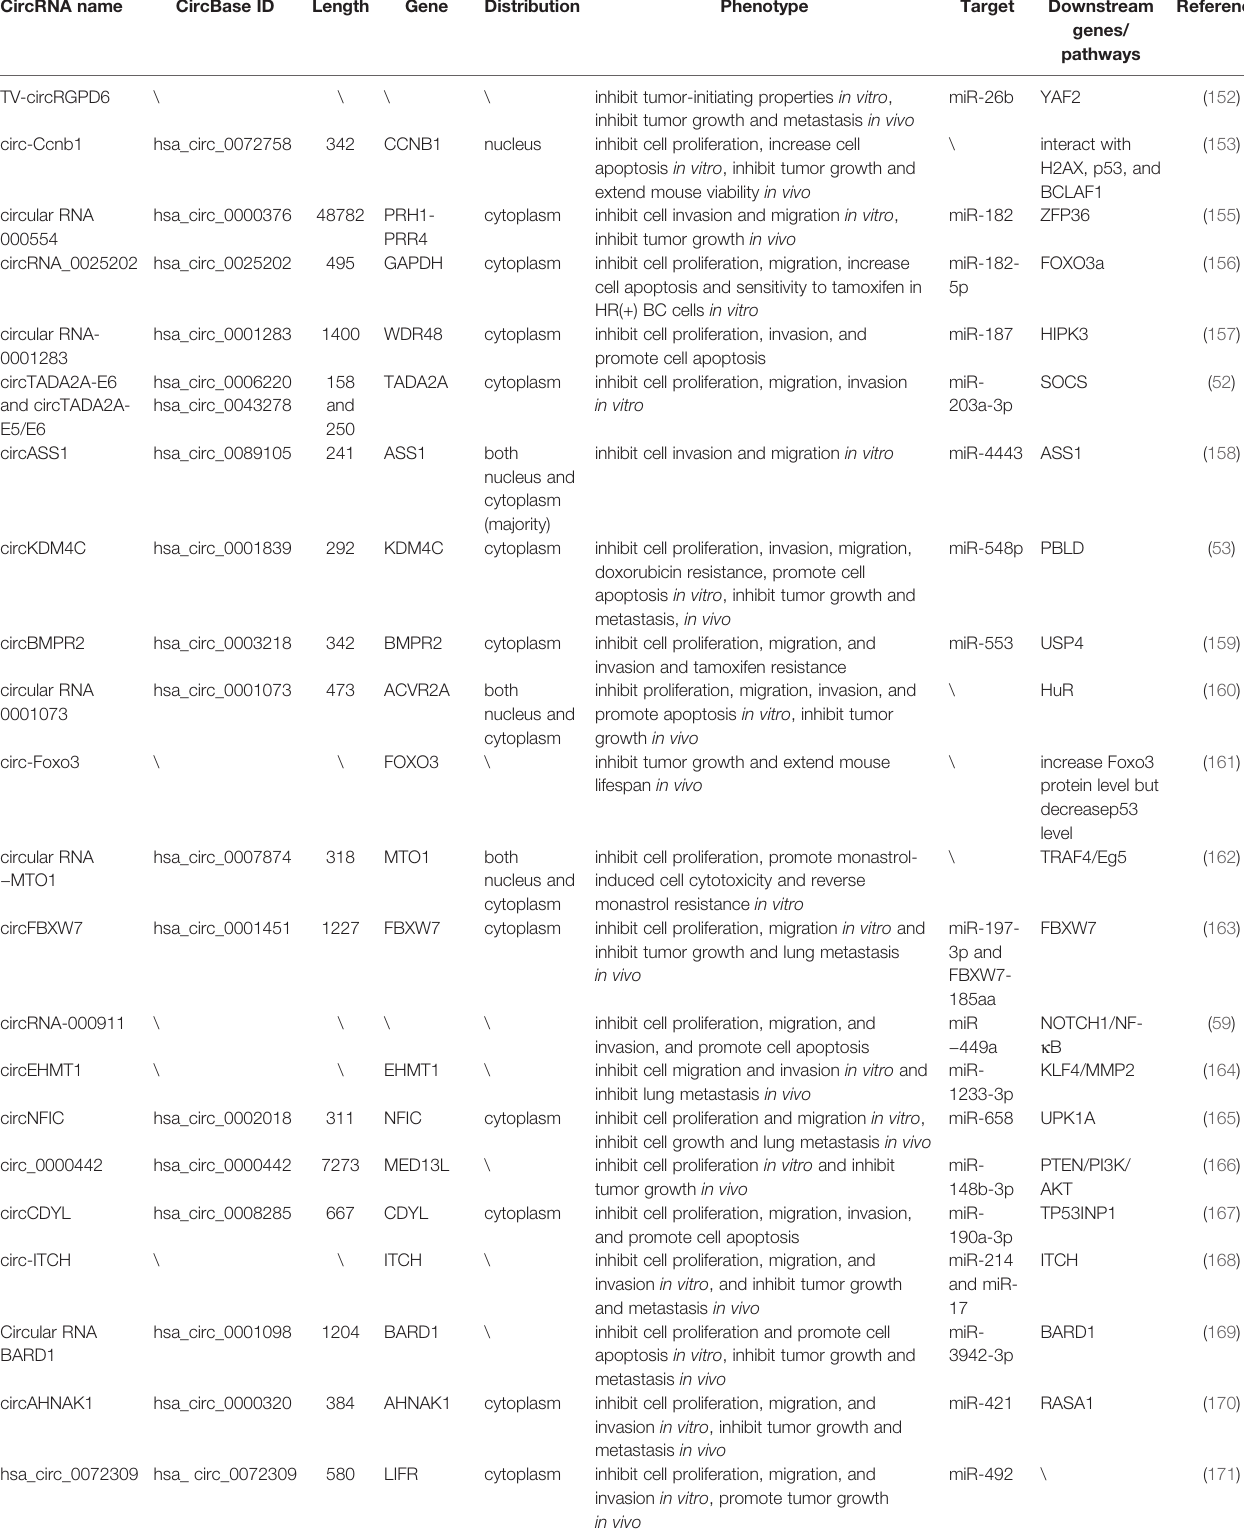
TABLE 3 | CircRNAs with tumor suppressive functions in breast